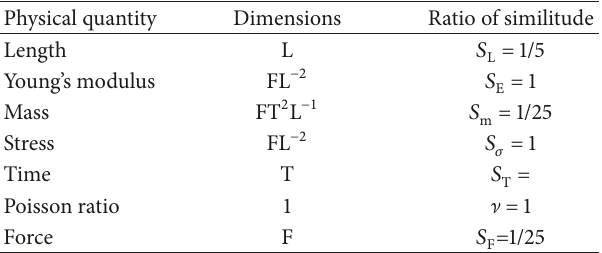
Table 1: Similarity relationship of the